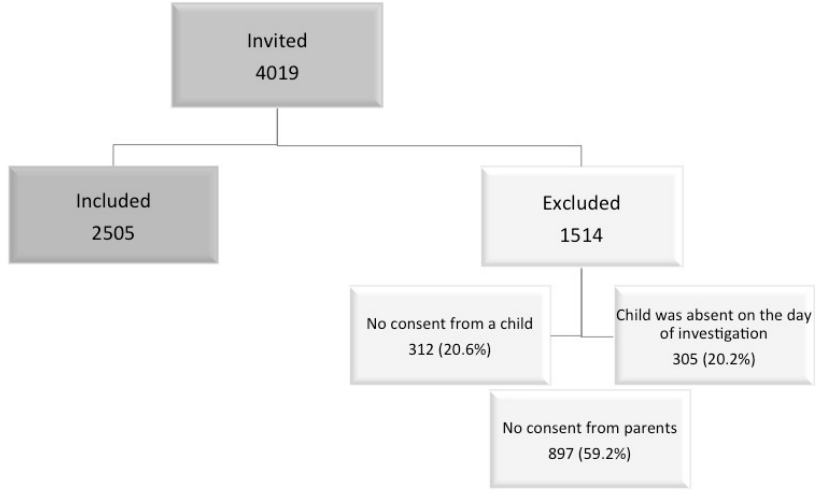
Figure 1. Flow diagram of the data collection process.